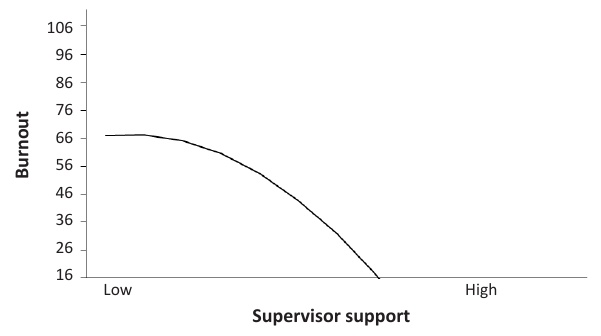
FIGURE 2: Curvilinear relationship between supervisor support and burnout.